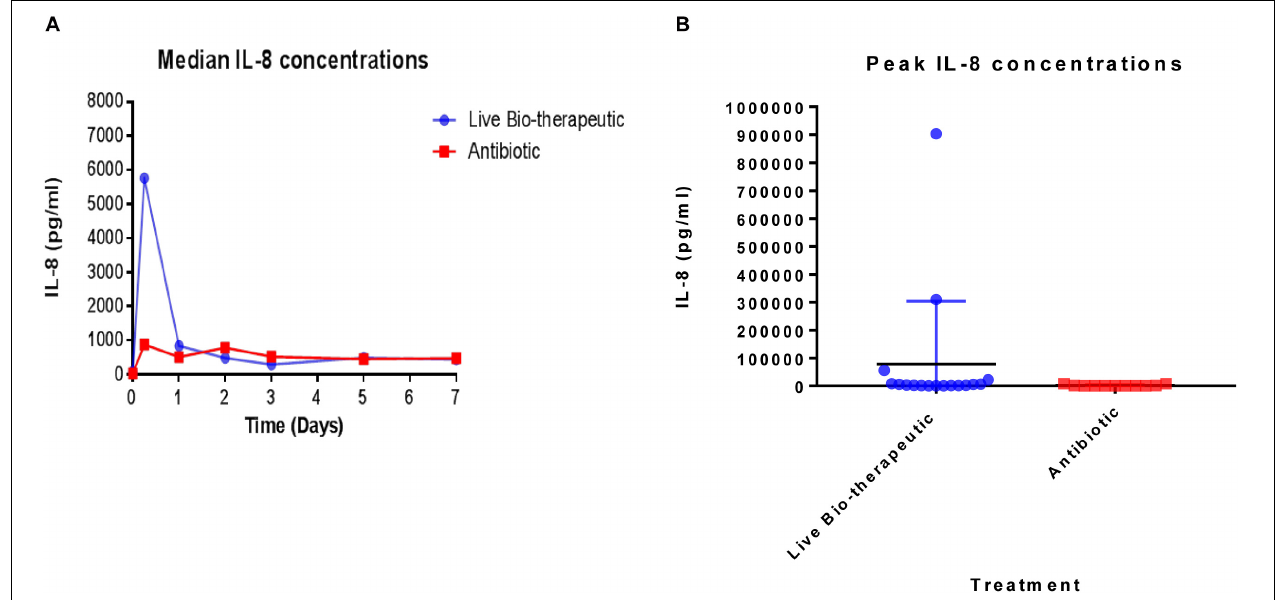
FIGURE 4 | IL-8 concentrations quantified in milk samples from mastitic cows treated with the ‘live bio-therapeutic’ formulation or the commercial antibiotic. (A) Determination of median IL-8 titres (pg/ml) by ELISA from various milk samples obtained from different cows over time. These cows displayed mastitis and were treated with either the ‘live bio-therapeutic’ emulsion or the commercial antibiotic. (B) Peak IL-8 concentrations in milk samples obtained from various cows treated for clinical/sub-clinical mastitis with either the ‘live bio-therapeutic’ formulation or the commercial antibiotic. Each dot represents milk samples obtained from different quarters treated with the above-mentioned therapies.